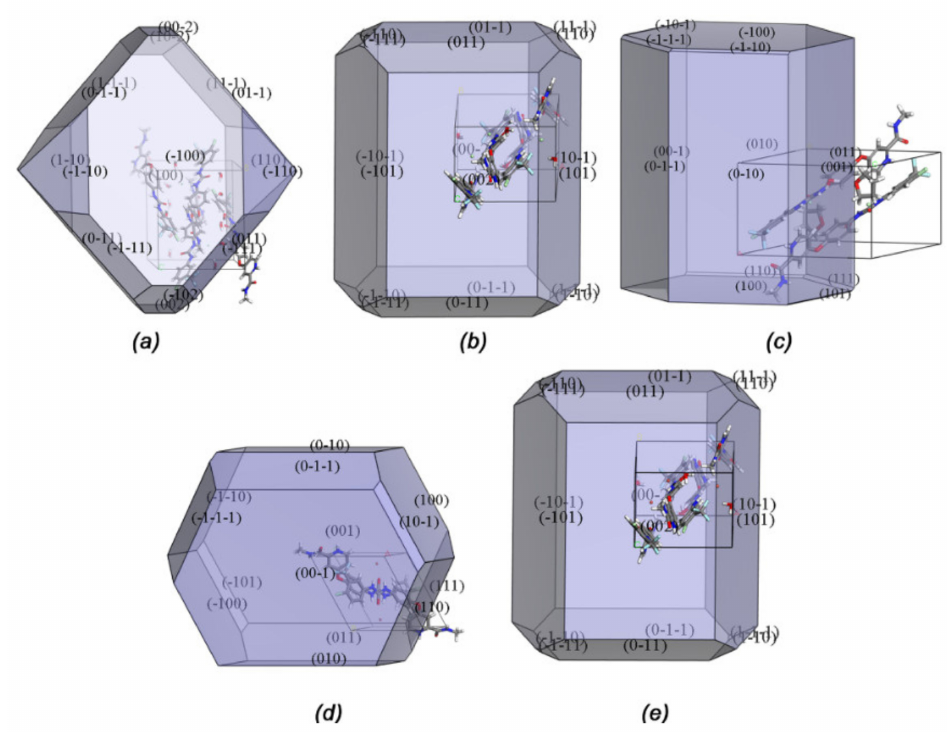
Figure 2. Simulated BFDH morphologies of ( a – e )